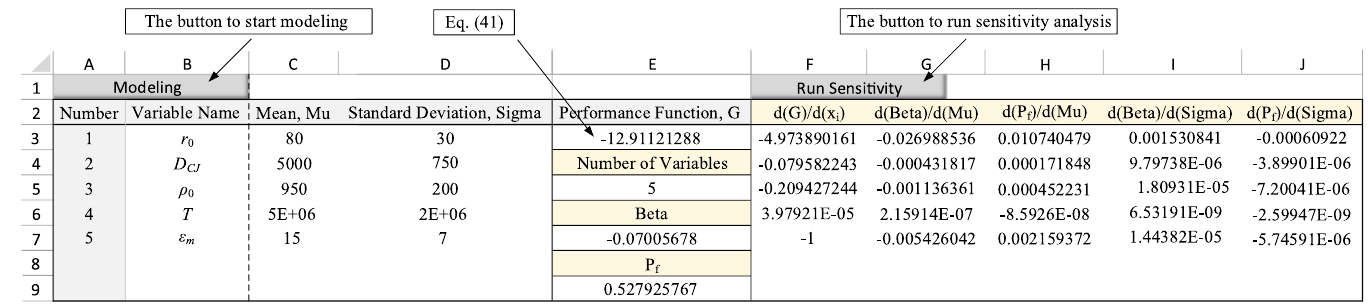
Fig 8. Sensitivity derivatives for the first example considering the model uncertainty.